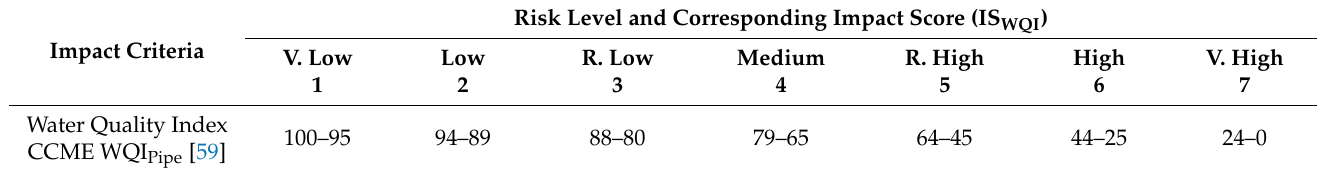
Table 3. Risk level and corresponding impact score based on the water quality index.